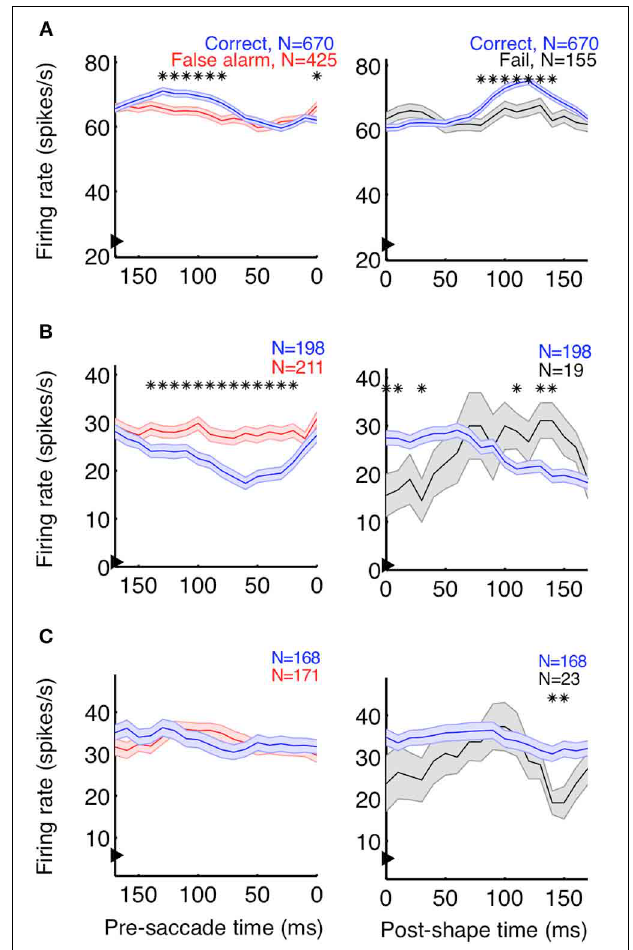
FIGURE 3 | Event-aligned firing rates of some units suggest task relevance. Example units from Monkey Z (A) and Monkey J (B,C) are shown. The left plots depict the average saccade-aligned firing rates for correct (shape + saccade; blue) and false alarm (no shape + saccade trials; red) trials, demonstrating changes in firing rate due to the stimulus, when behavior is constant. The right plots depict shape-aligned firing rates for correct (shape + saccade; blue) and failure (shape + no saccade; black) trials, demonstrating changes in firing rate reflective of subsequent behavior when the stimulus is constant. The units in (A,B) appeared to reflect both the presence of a shape and the animal’s detection of shapes, although firing rates were modulated in opposite directions and the effect in (B) between correct and failed trials was less clear. The neuron represented in (C) showed no clear task-relevant modulations. Firing rates were calculated in 50ms bins, with the x-axis representing the bin edge closest to the relevant event (shape or saccade). Arrows on the y-axis indicate average baseline firing rate, from 150ms before noise stimulus onset until 50ms after. Shaded regions represent SEM, and asterisks indicate bins in which the firing rates of the two types of trials were significantly different ( p <